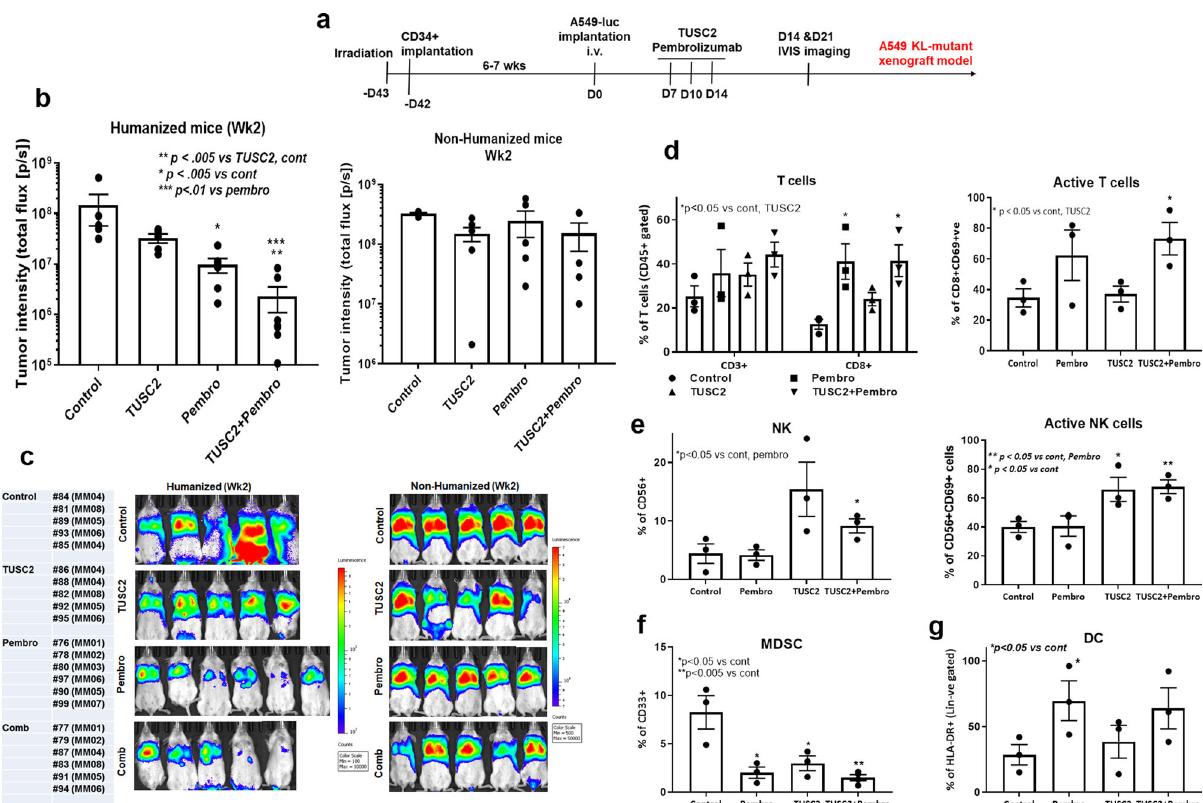
Fig. 2 Synergistic antitumor effect of TUSC2 immunogene therapy with pembrolizumab on KRAS/LKB1 lung metastases in the humanized mouse model. a Treatment strategy shows that tumors were implanted into 6 – 7 weeks post humanized mice and lung metastasis were treated with TUSC2 injection through i.v. (25 ug/mouse) on every 3 days for 3X and pembrolizumab (250 ug/mouse) on every 3 – 4 days for 3X. b Tumor-bearing humanized mice were images by IVIS 200 and tumor intensity was measured and quantitated and level of tumor reduction by treatment was shown in both humanized and non-humanized mouse models. c bioluminescence imaging of performed by IVIS 200 to visualize the intensity of tumor burden on mice in different treatment groups both in humanized mice and non-humanized mouse system. This experiment was repeated three times with 7 – 8 mice/group used in each experiment, bars, SD. * P < 0.05, ** P < 0.005, *** P < 0.0005. d Tumors were analyzed through single cells preparation and stained for human T and activated T cells in tumor microenvironment. e in fi ltrating NK and activating NK cells were analyzed in tumors. f , g Level of MDSC and HLA-DR + DC in tumor were determined through fl ow cytometry analysis of tumor tissues. Data are shown as mean percentage ± SD, n = 5. * P < 0.05, ** P < 0.005, *** P <